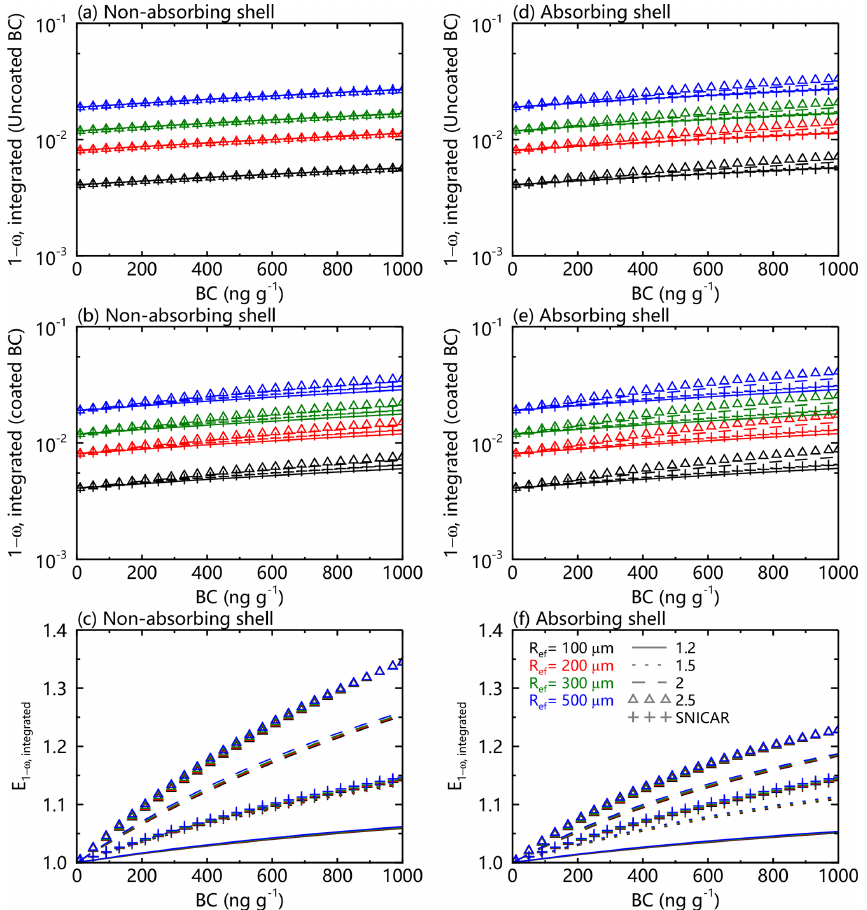
Figure 5. Spectrally weighted snow single-scattering co-albedo (1 − ω integrated ) from 300–2500nm of the typical surface solar spectrum at midlatitudes–high latitudes from January to May for (a) uncoated and (b) coated BC particles under the assumption of a nonabsorbing shell. Panels (d) and (e) are the same as (a) and (b) , respectively, but under the assumption of an absorbing shell. Panel (c) shows the ratios ( E 1 − ω, integrated ) of the spectrally weighted snow single-scattering co-albedo for coated versus uncoated BC particles under the assumption of a nonabsorbing shell. Panel (f) is the same as (c) but under the assumption of an absorbing